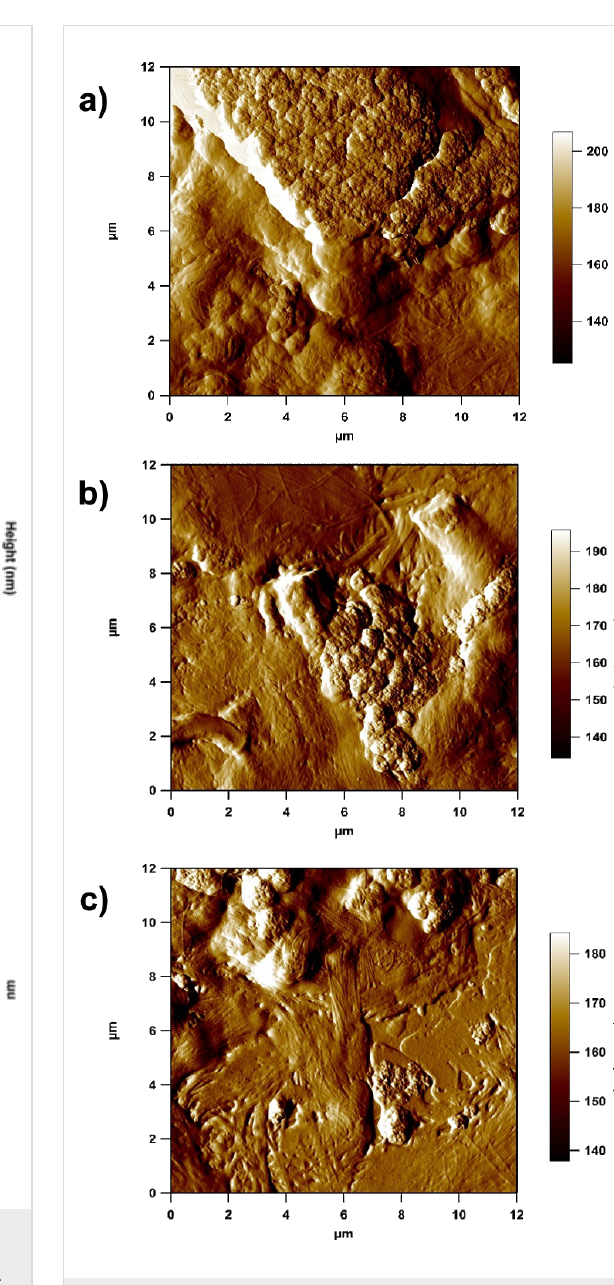
Figure 3: 12 μ m amplitude images of highly agglomerated tattoo ink particles in the collagen network.